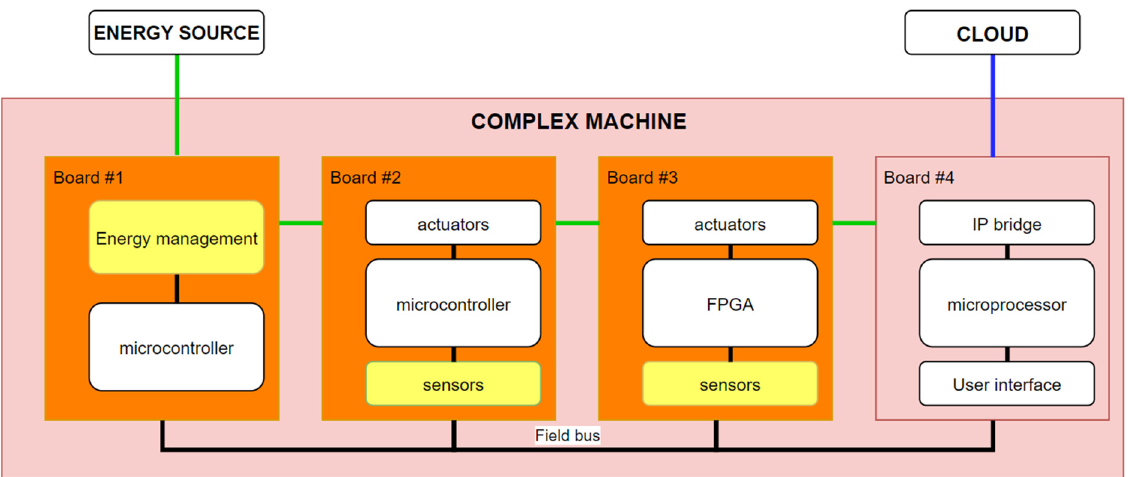
Figure 9. Diagram of an example of a complex machine with layer differentiation (Yellow, sensor level; orange, board level; red, machine level).